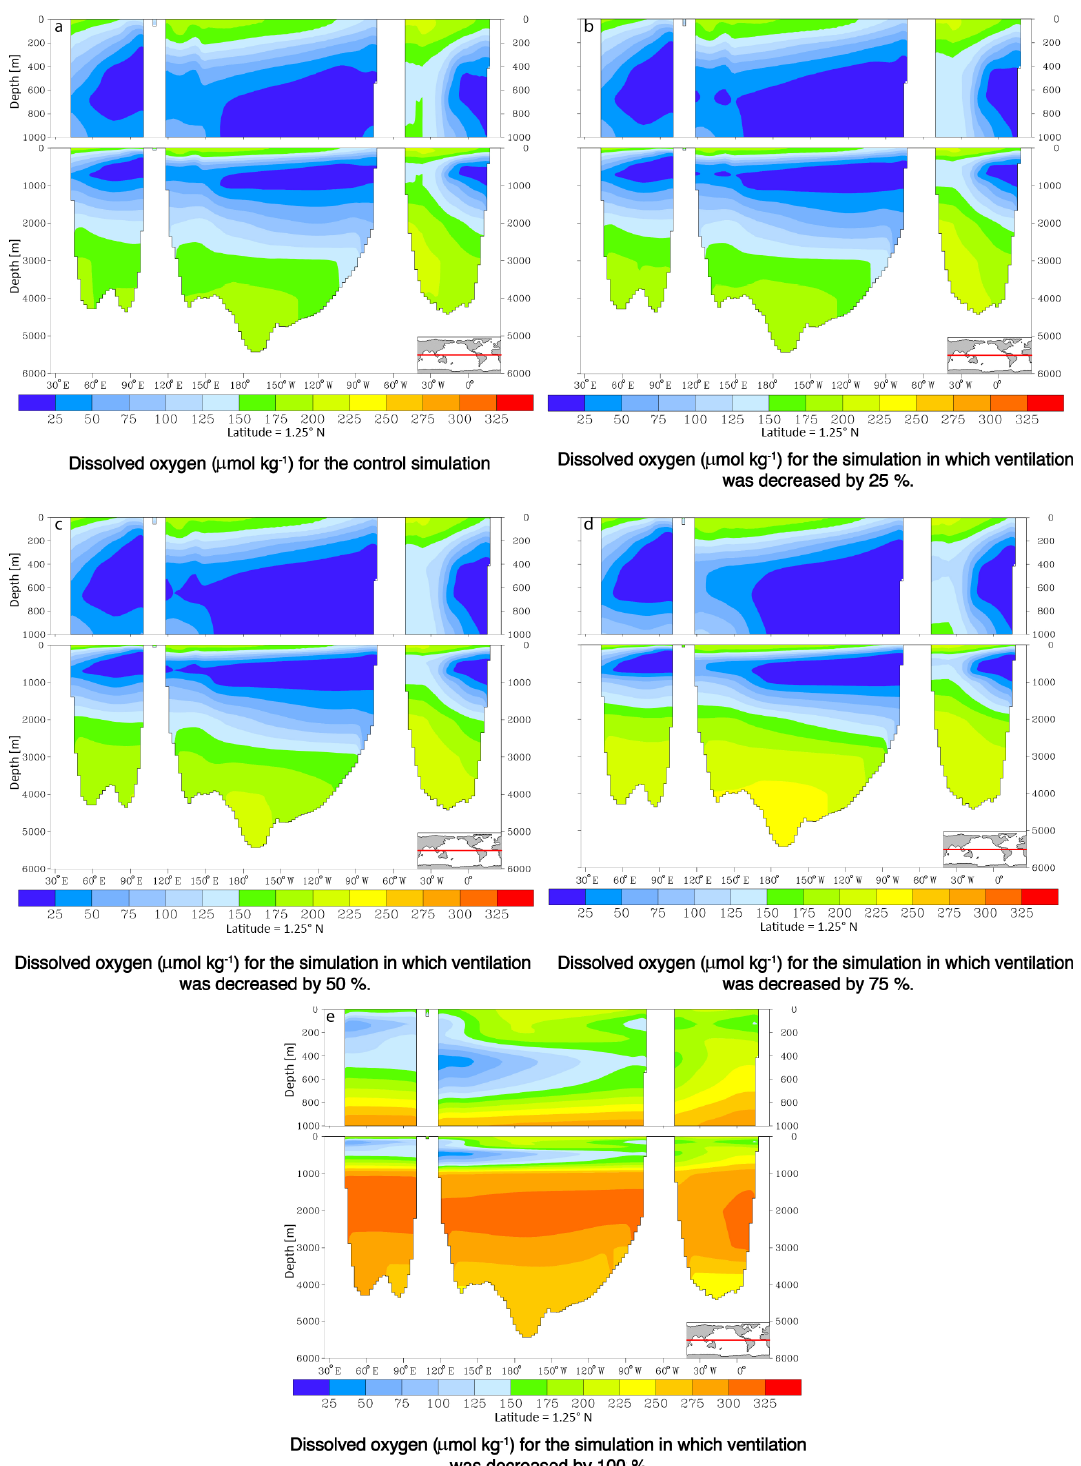
Figure 4. Reduced ventilation simulations at (a) reference (100% ventilation), (b) 25% reduction, (c) 50% reduction, (d) 75% reduction and (e) 100% reduction in